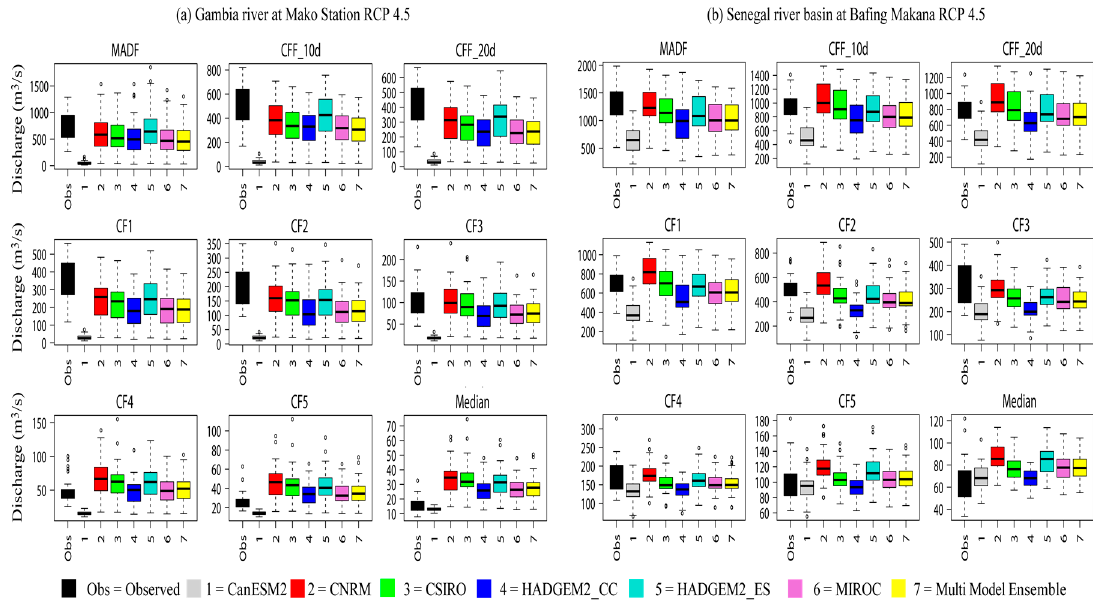
Figure 6. Evolution of characteristic flow rates by 2050 under the RCP4.5 scenario.